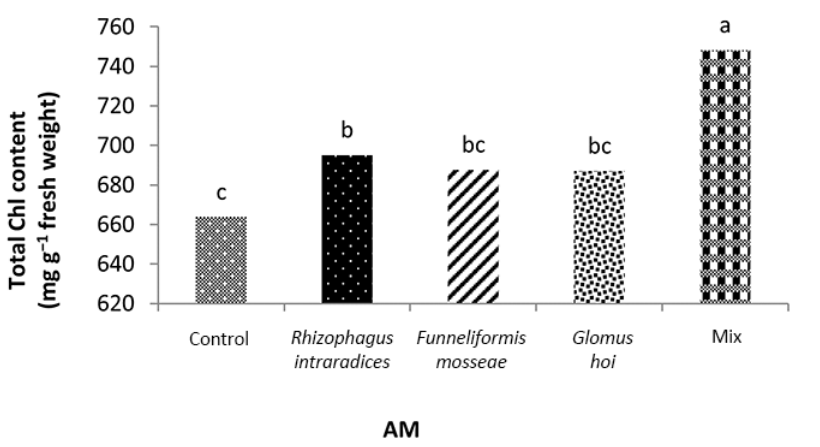
Figure 7 Effect of arbuscular mycorrhization (AM) on total chlorophyll (Chl) content in